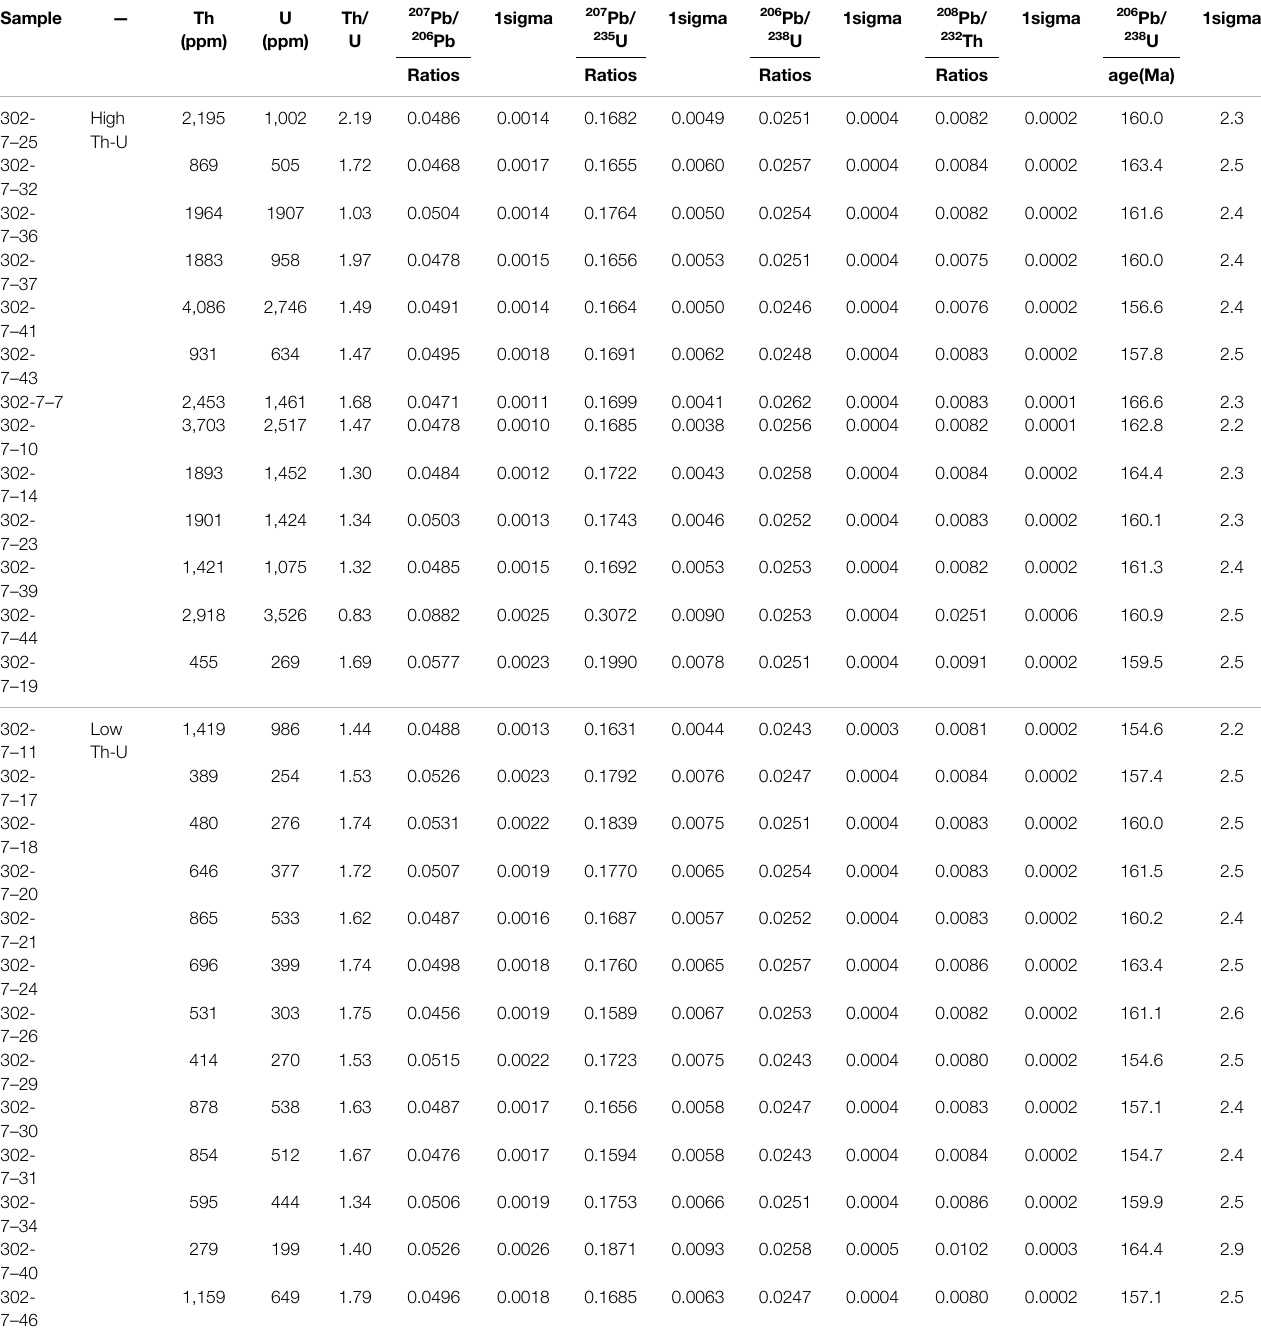
TABLE 2 | Results of LA-ICPMS zircon U – Pb analyses for the porphyritic biotite granite from the Jianfengling pluton.